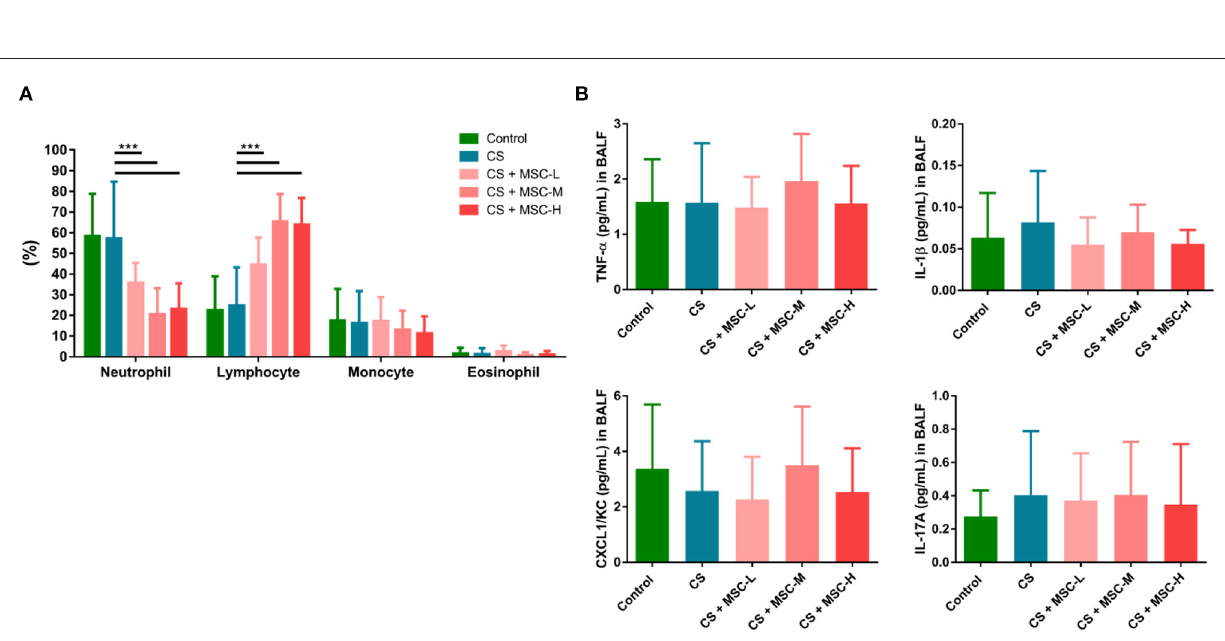
Frontiers in Medicine |